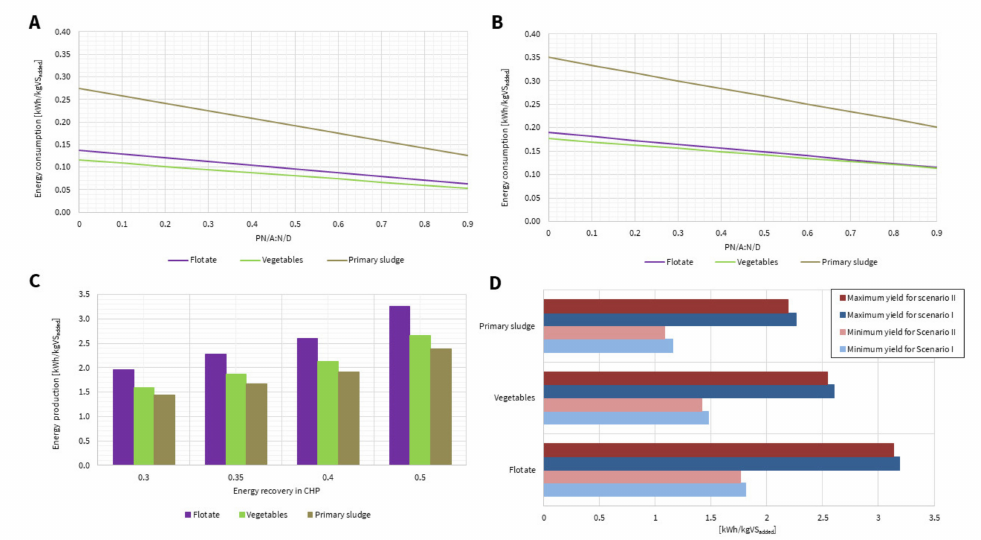
Figure 10. Electric energy balance for the three co-substrates in relation to 1 kg VS added : ( A ) energy consumption for nitrogen removal for scenario I; ( B ) energy consumption for nitrogen removal for scenario II; ( C ) the amount of energy production in the CHP systems; ( D ) energy